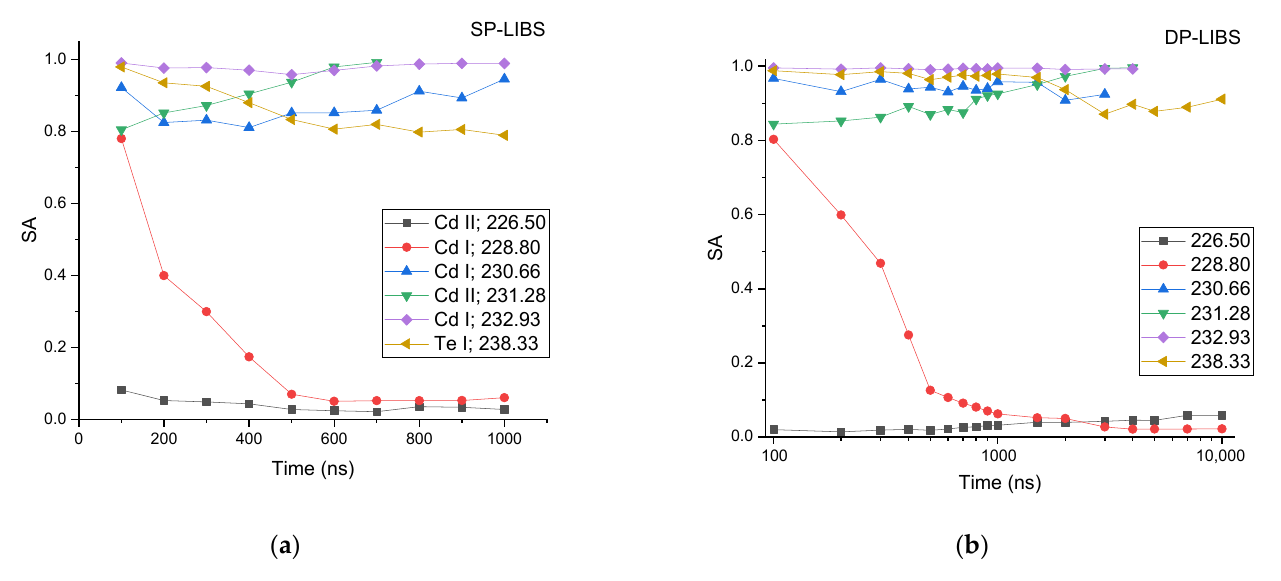
Figure 7. Time-resolved evolution of self-absorption coefficient SA for selected Cd and Te transitions for ( a ) SP-LIBS and ( b ) DP-LIBS. Wavelengths are given in nanometers.